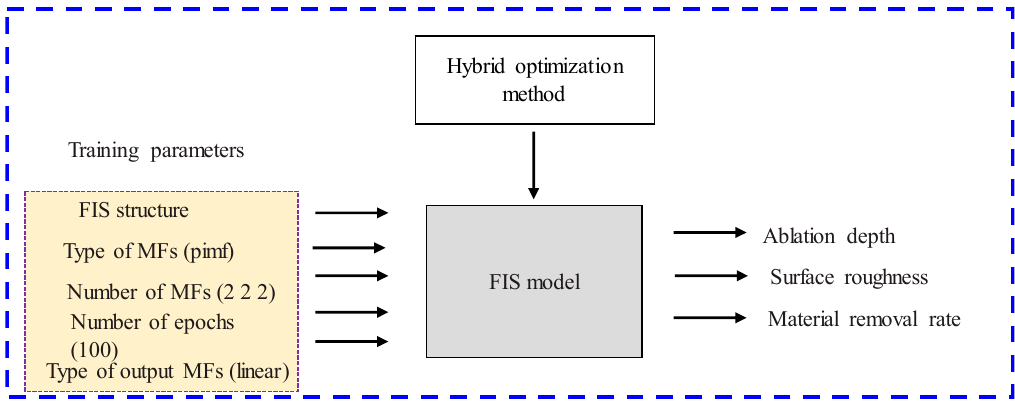
Figure 10. Initially selected parameters of adapted FIS algorithm for multiple outputs.